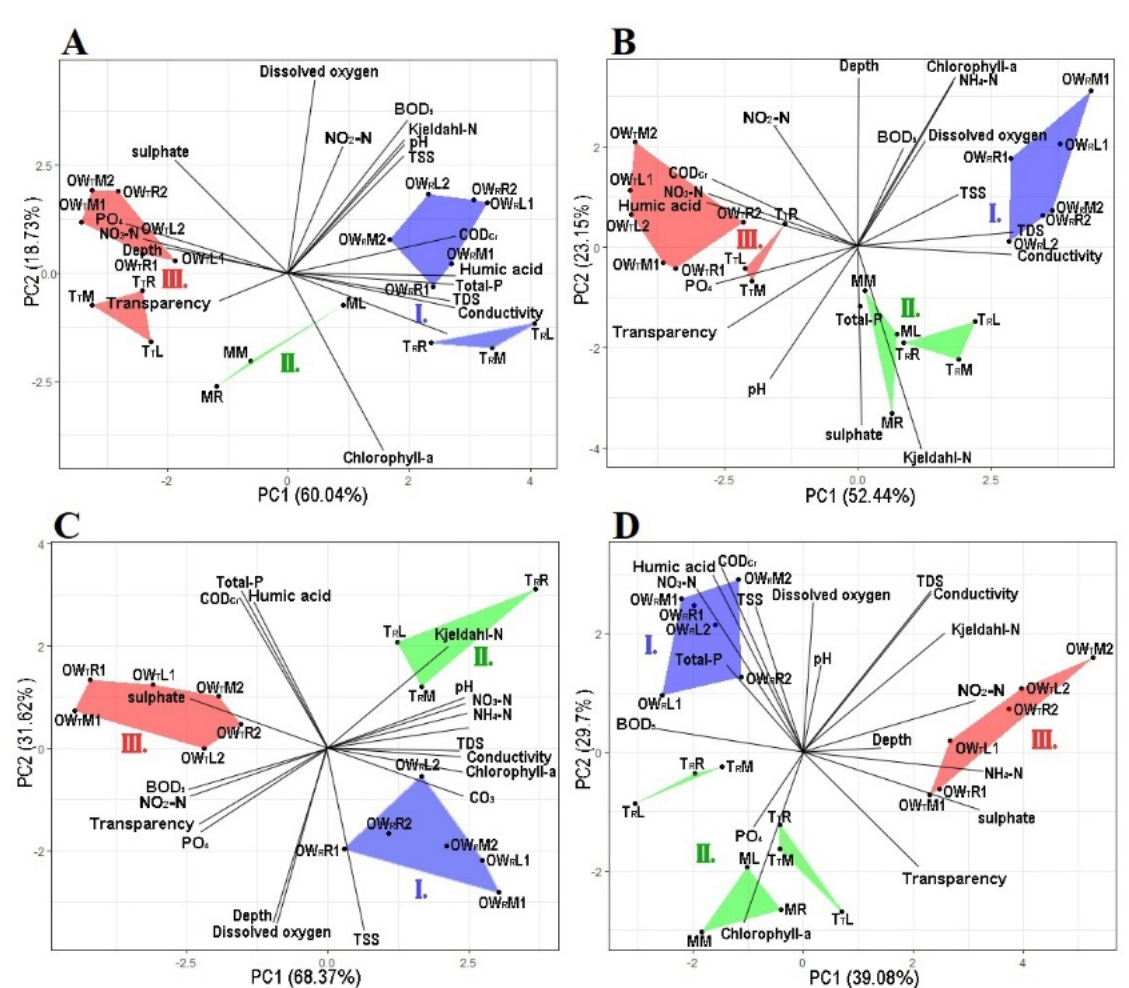
Figure 2. The principal component analysis based on the physico-chemical variables at each sampling point. Graph ( A ): April, Graph ( B ): June, Graph ( C ): July, Graph ( D ): October. The groups are represented by the following colors, Group I is blue, Group II is green and Group III is red. OW R represents the open water zone of the Rakamaz area with the sampling transects and the sampling points. T R represents the transitional zone between the open water zone of Rakamaz area (OW R ) and the middle zone (M) which is characterized by a large macrovegetation coverage. T T represents the transitional zone between open water zone of Tiszanagyfalu area (OW T ) and the middle zone (M). OW T represents the open water zone of the Tiszanagyfalu area. The numbers 1 and 2 represent the transects inside the zones. The letter L represents the left part of the transects, M represents the middle part of the transect, and R represents the right part of the transects; these abbreviations apply to all sampling